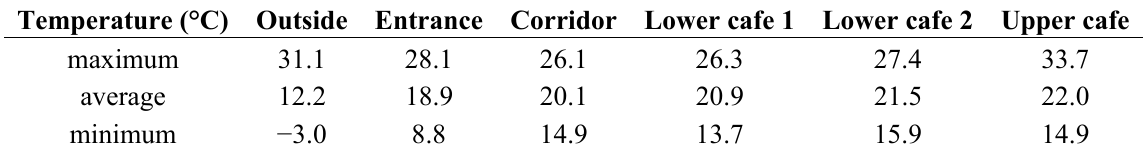
Table 6. Northern Europe atrium—temperatures at different positions in the atrium over the year (data adapted from [19]).